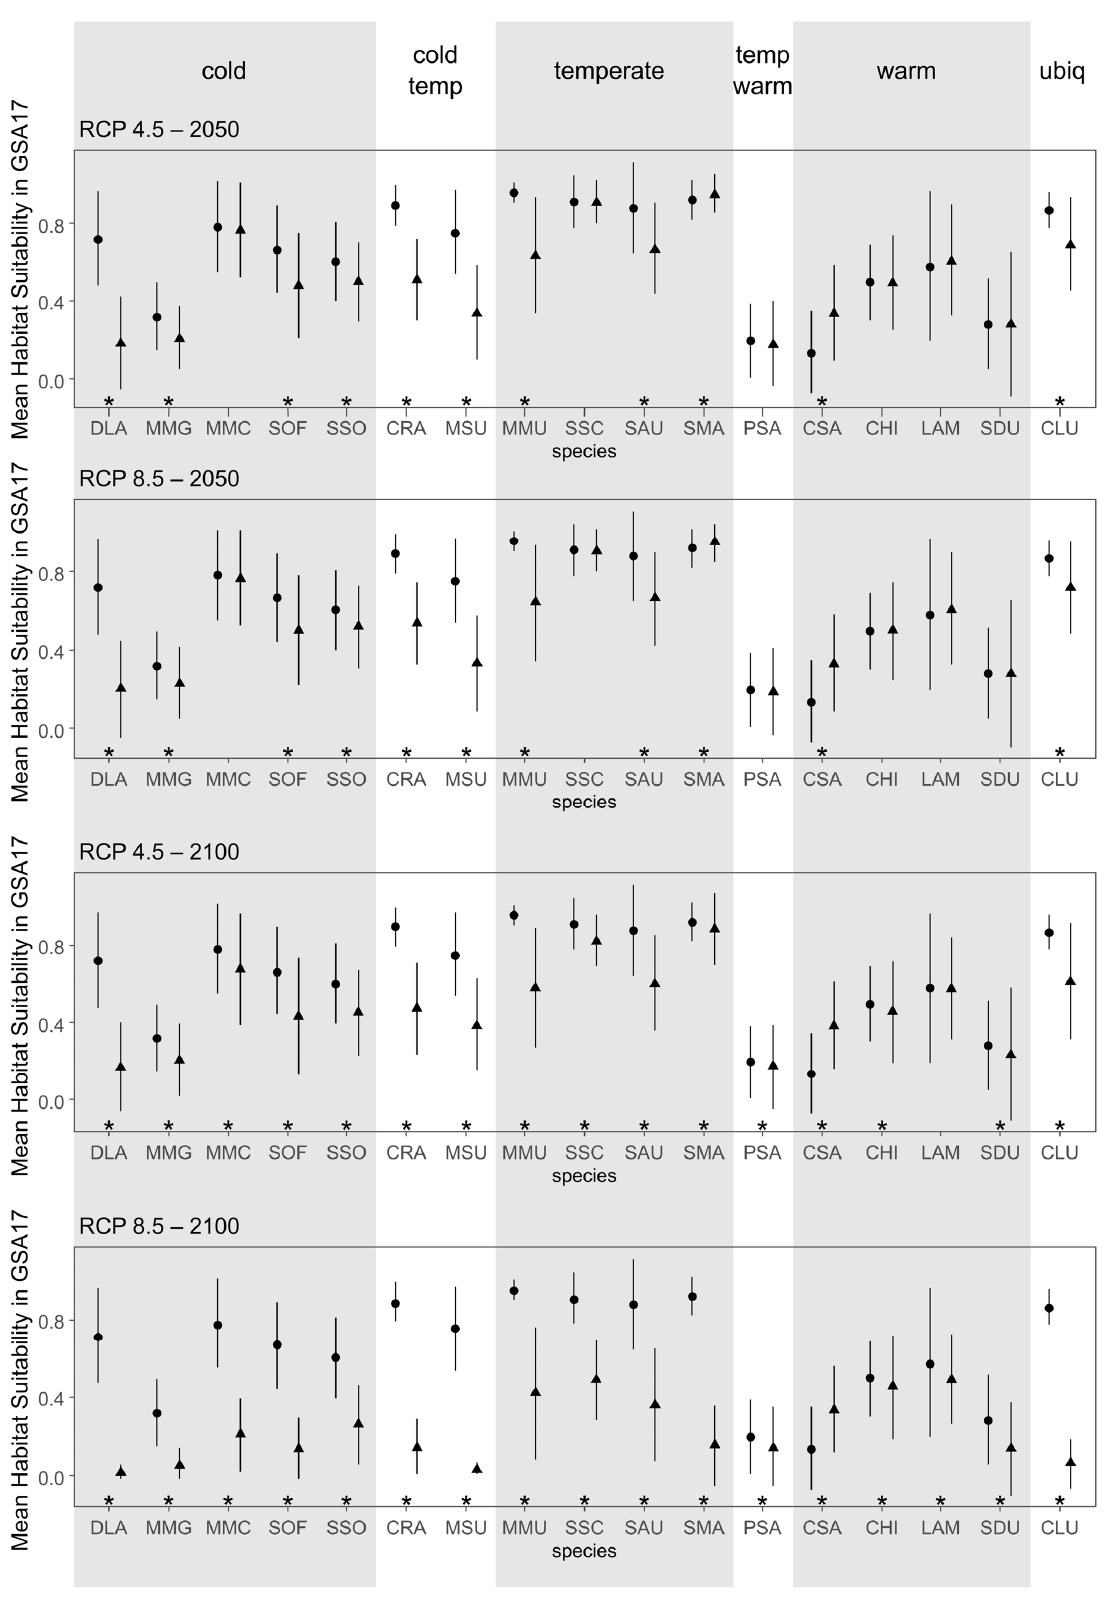
Figure 3. Mean habitat suitability ( ± st. dev.) of the 17 species targeted by SSF (see Table 1 for species acronyms), at present (circles) and in the future (triangles) according to the four projections considered. * marks significance differences for p <